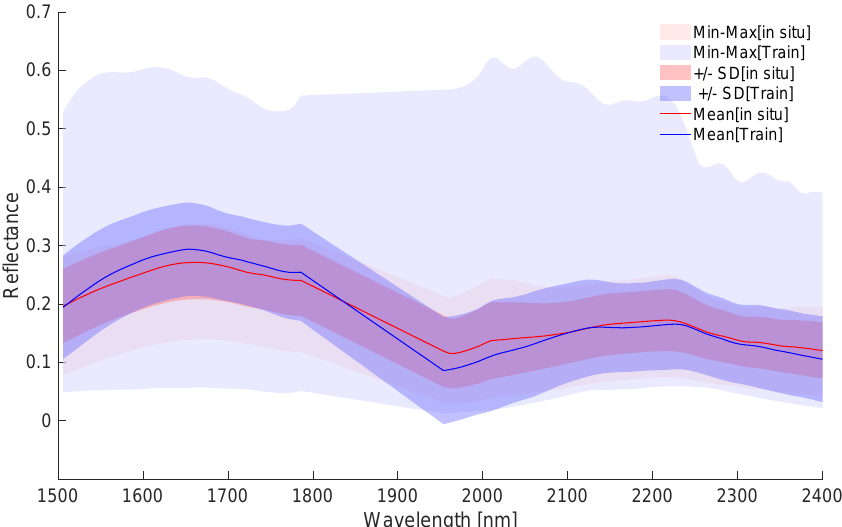
Figure 7. Illustration of total range of training versus in situ reflectances from the Slovakian campaign, with mean and SD. Training data base (Train) was simulated with PROSAIL-PRO and optimized with